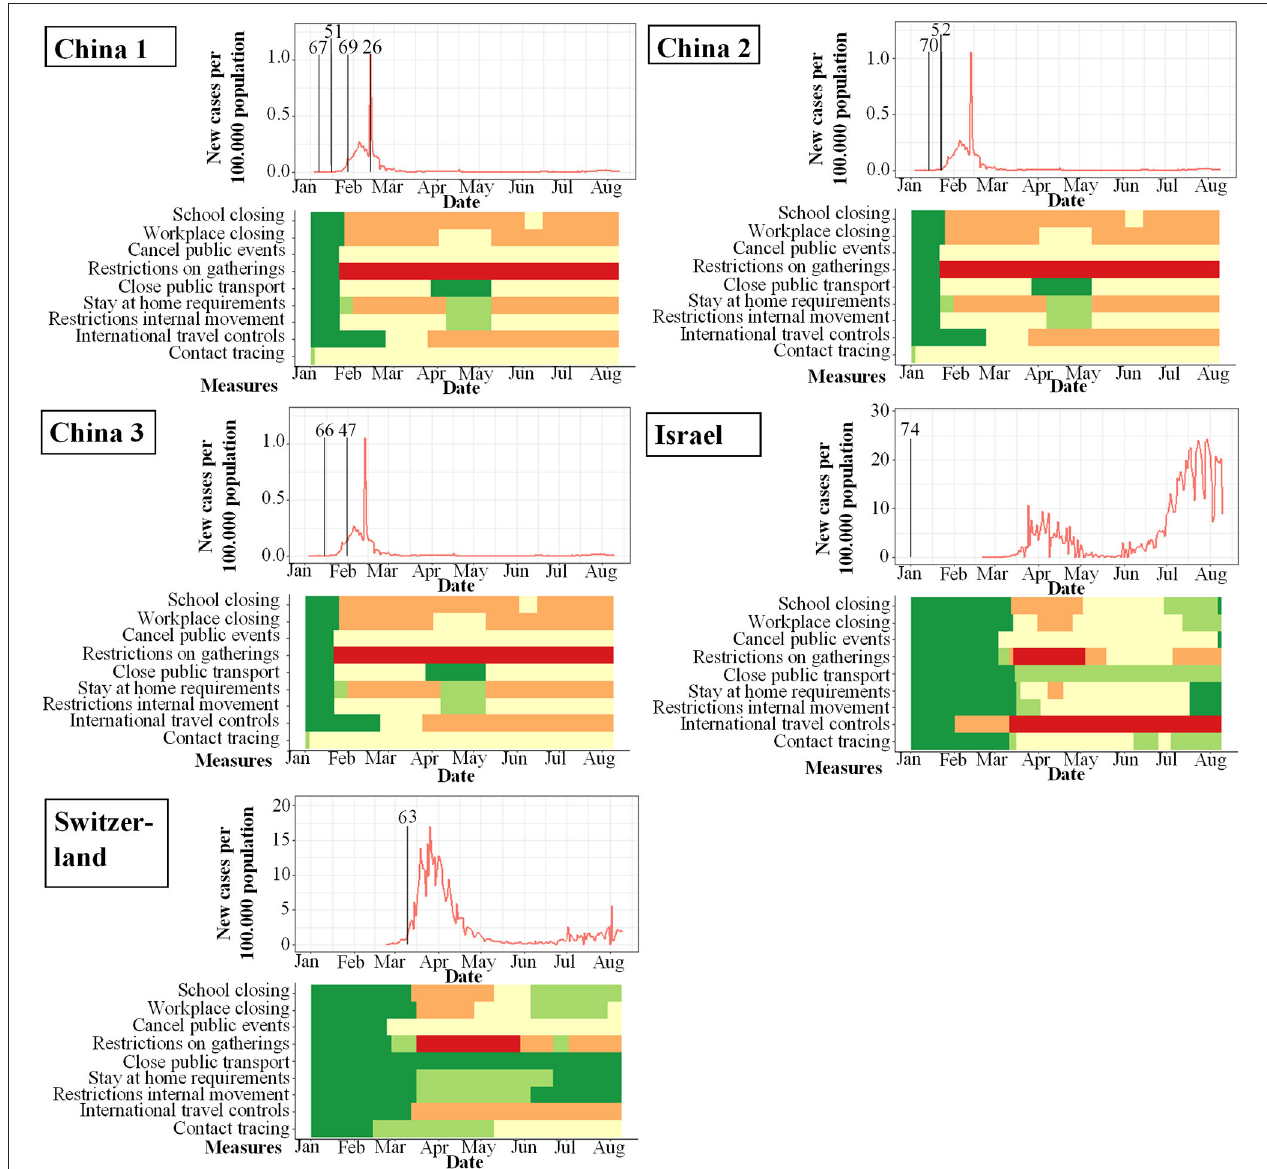
FIGURE 4 | Studies included in qualitative analysis and their study start (indicated by vertical bar) in proportion to incidence of new infections with SARS-CoV-2 per 100.000 per day (y-axis) and changes over time (x-axis). Local response reactions to reduce spread of SARS-CoV-2 are shown below the x-axis in colored bars. Green bars mean no restrictions, red full restrictions, e.g., shut down of transport, no gatherings. Dataset of the figure is available in the Supplementary Material .